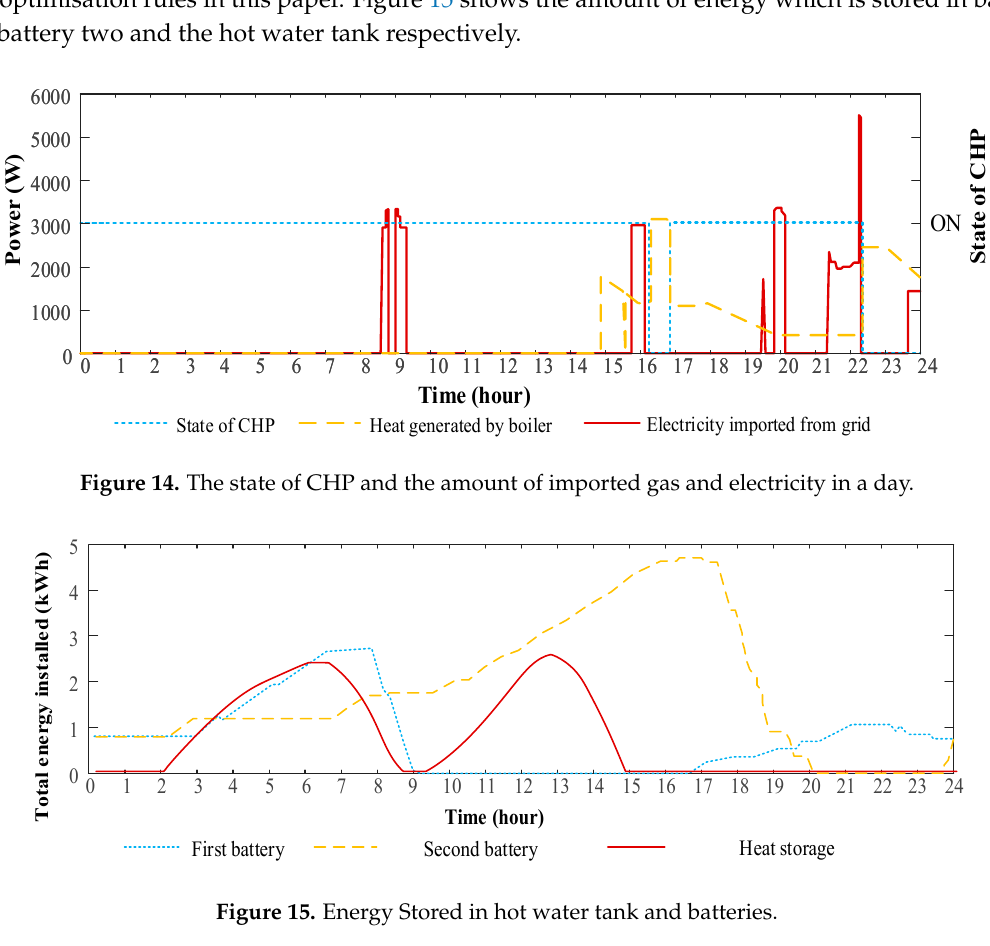
Figure 13. Battery initial energy in (kWh) vs domestic building daily electricity cost.